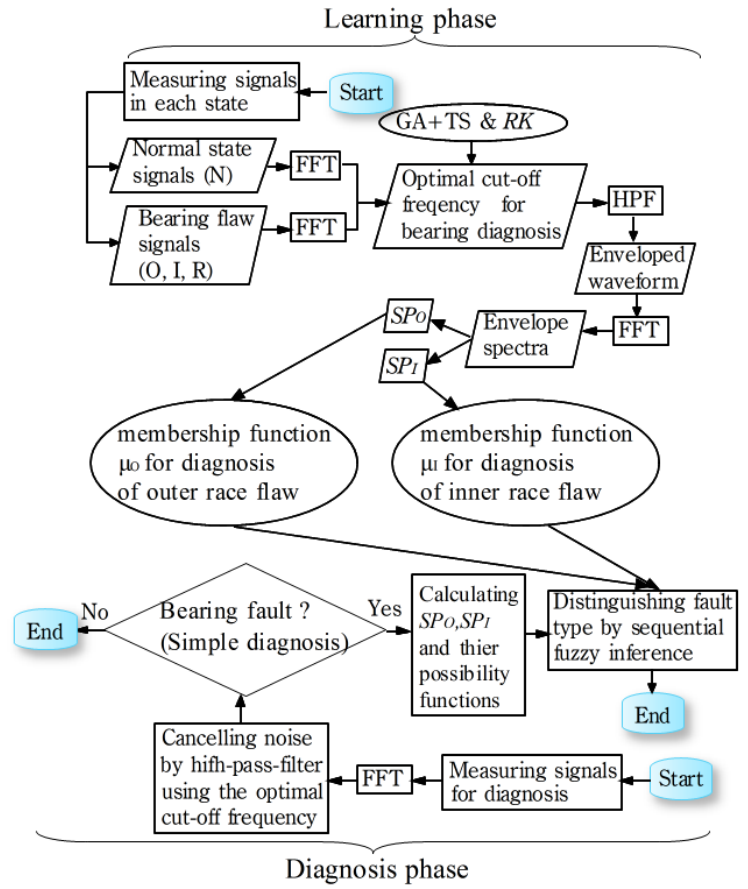
Figure 2. Detail flowchart of the proposed bearing fault isolation.